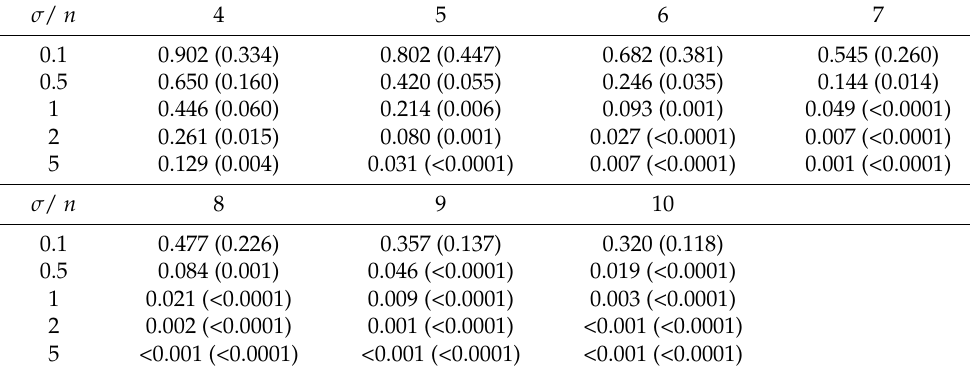
Table 1. Comparison between empirical probabilities with lower bounds computed by Theorem